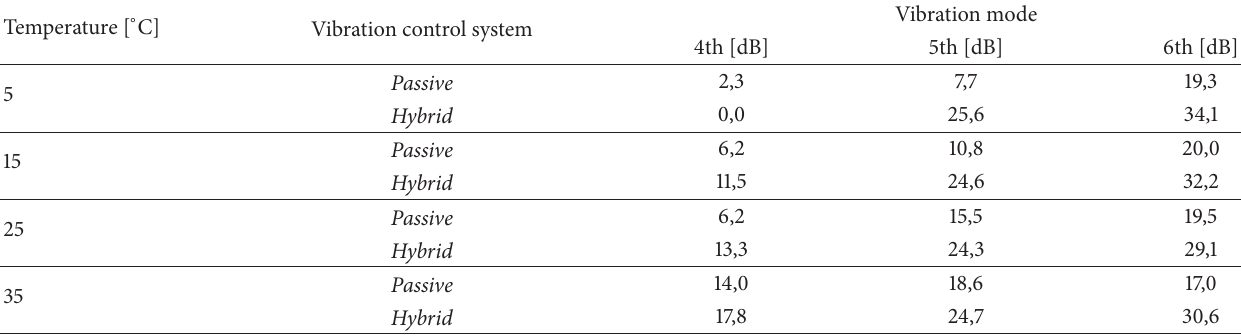
Table 5: PVCS and HVCS performance (vibration attenuation related to the uncontrolled beam vibrations levels), resonance peak analysis. Temperature [ ∘